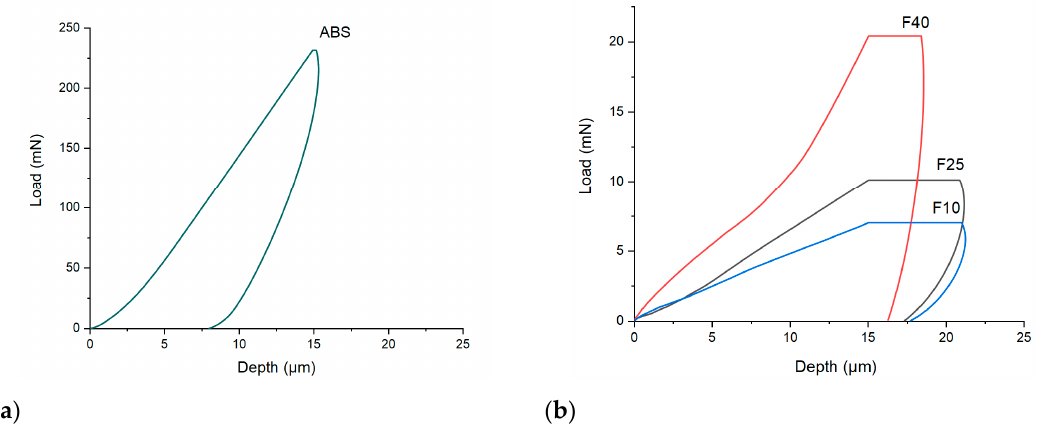
Figure 3. ( a ) Nanoindentation analysis of the ABS filament; ( b ) nanoindentation analysis of the core filaments with di ff erent drug loading: F10 (10% w / w paracetamol), F25 (25% w / w paracetamol), and F40 (40% w / w paracetamol).